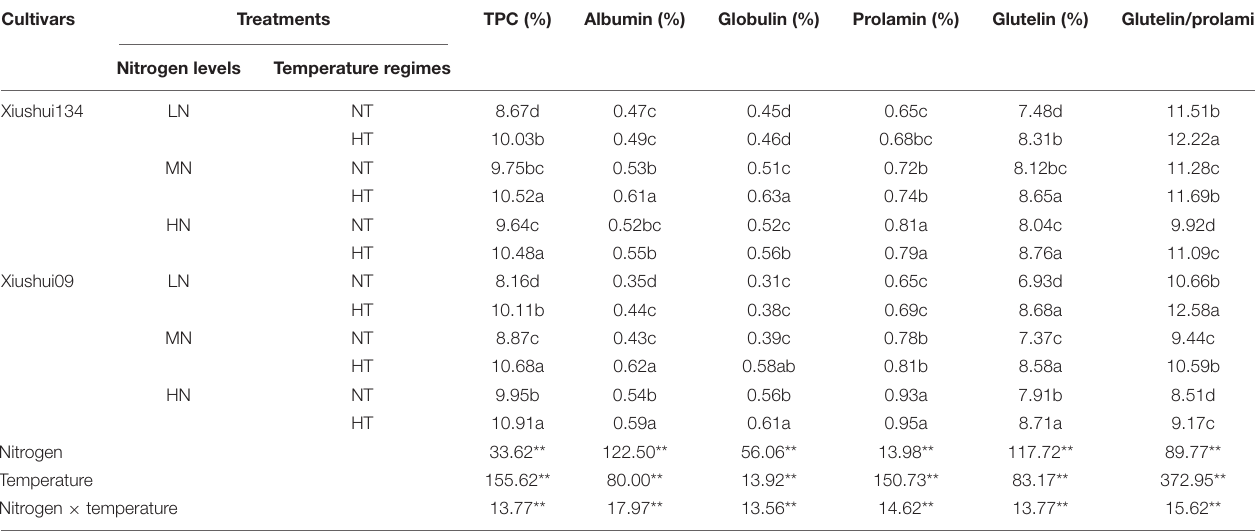
TABLE 6 | Difference in total protein content and its four compositions among different